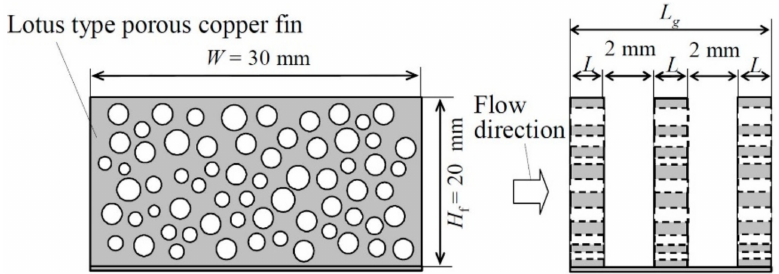
Figure 12. Schematic drawing of lotus-type structure samples for pressure drop measurement. Reproduced from [13], with permission from The Japan Society of Mechanical Engineers and The Heat Transfer Society of Japan, 2010.